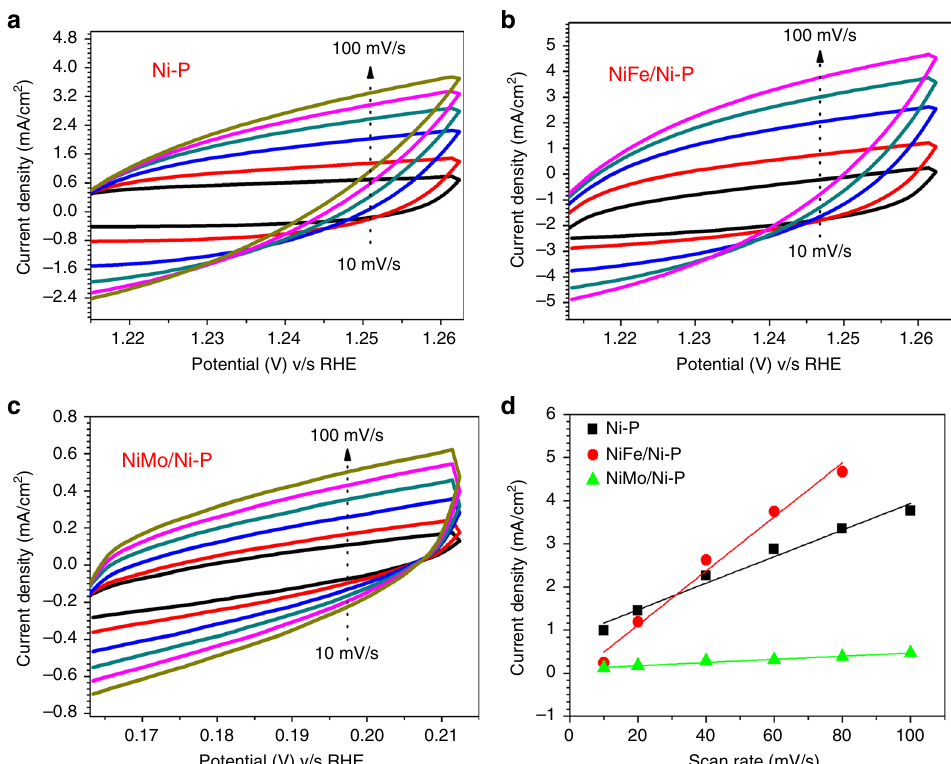
Fig. 7 Electrochemical active surface area using CVs recorded in non-faradic region at different scan rates. a Ni-P; b NiFe/Ni-P; c NiMo/Ni-P; d Straight line fi ts of maximum anodic current density versus scan rate plots for Ni-P, NiFe/Ni-P and